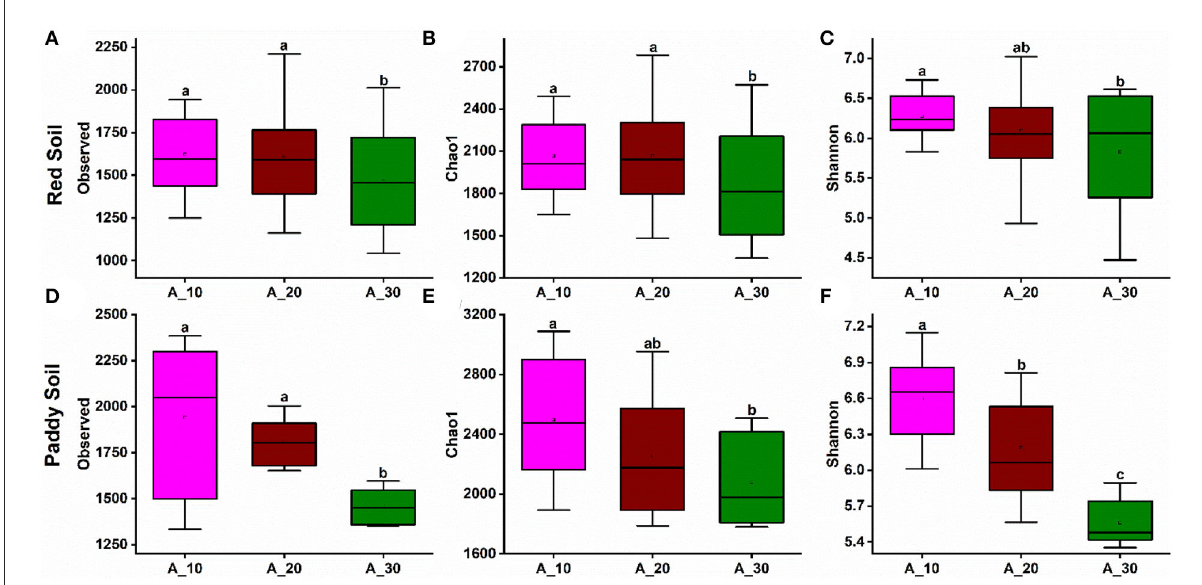
FIGURE3 Alpha diversity indexes under different tree ages. Changes in alpha diversity indices, including observed, Chao-1, and Shannon indices, were observed under different tree ages for (A–C) red soil and (D–F ) paddy soil. Here, Age_10, Age_20, and Age_30 denote the different pomelo tree ages of 10, 20, and 30 years,